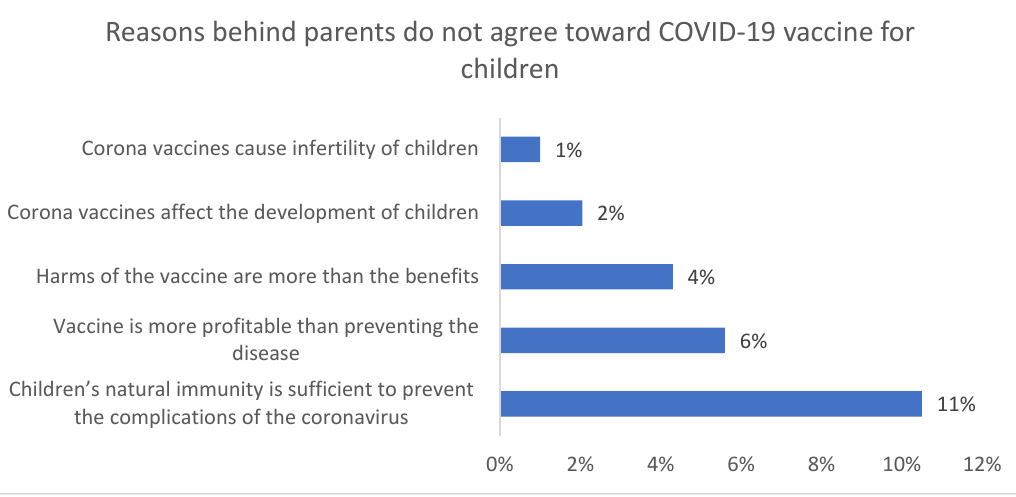
Figure 2. Reasons for parents’ disagreement to vaccinate their children for COVID-19..